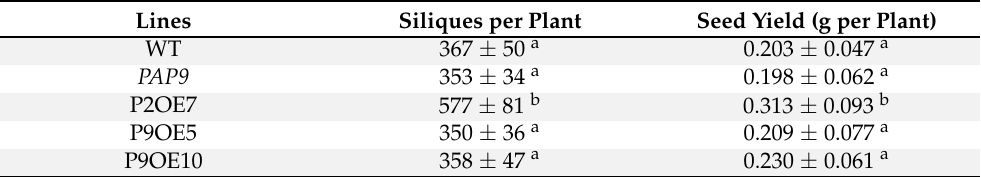
Table 1. Seed yield at maturity.